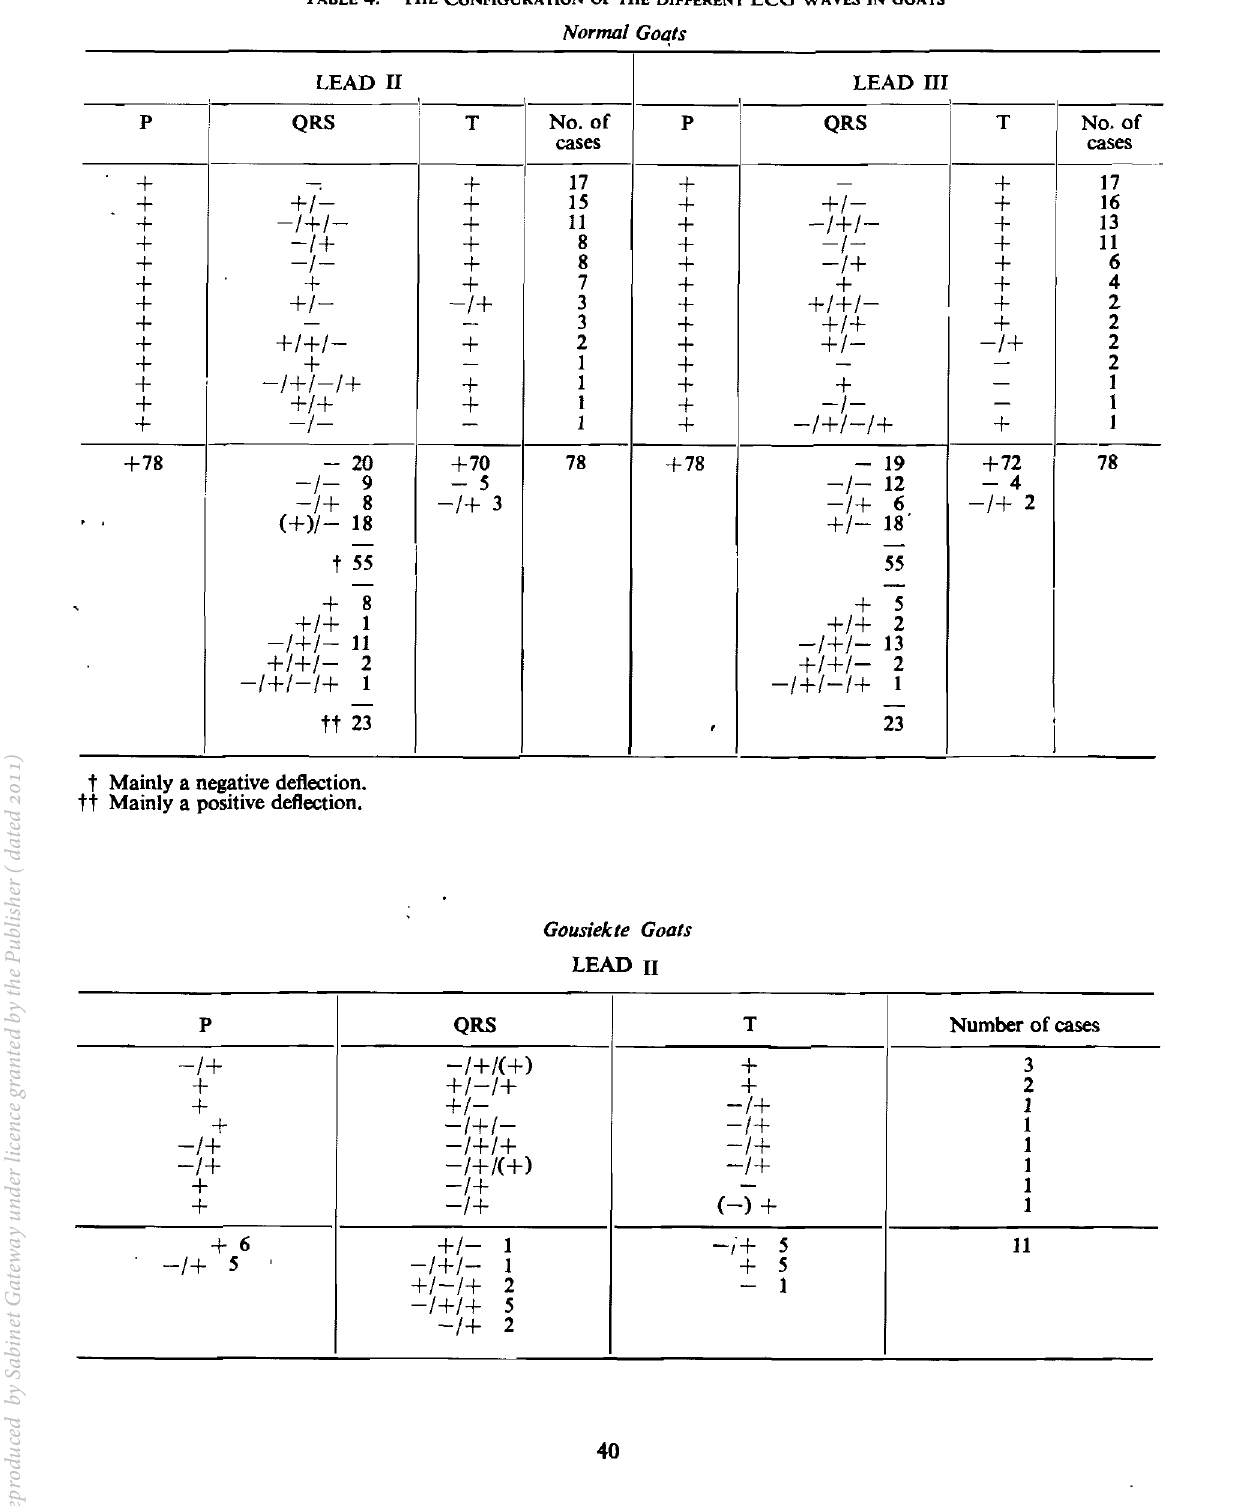
TABLE 4.- THE CONFIGURATION OF THE DIFFERENT ECG WAVES IN GOATS Normal